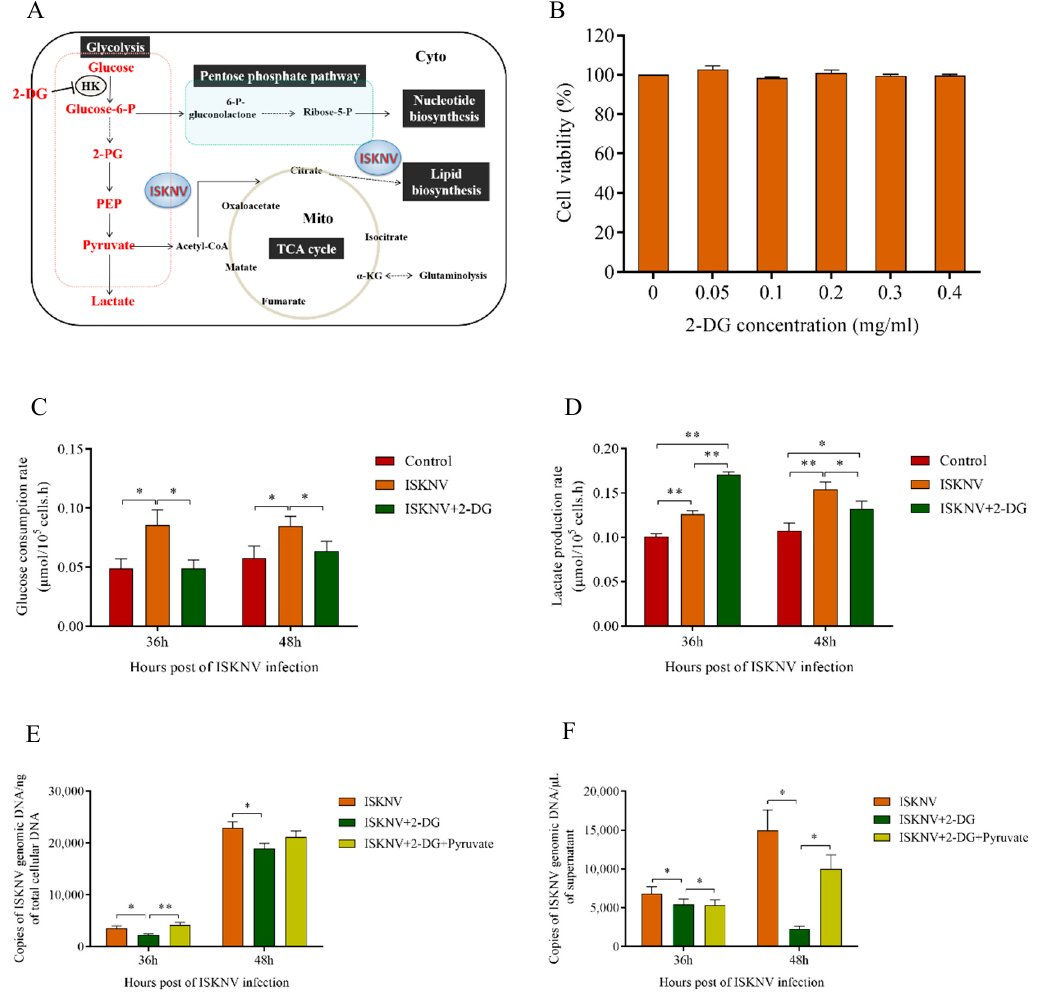
Figure 4. Aerobic glycolysis was required for efficient ISKNV multiplication. ( A ) Overview of cellular metabolism with glucose. 2-Deoxy-D-glucose (2-DG) inhibited glycolysis by inhibiting the expression of HK. ( B ) CPB cells were cultured in complete medium treated with 0–0.4 mg/mL of 2-DG, and the cell viability was detected by MTS assay at 72 hpi. ( C , D ) The glucose consumption and lactate production in ISKNV infected CPB cells. ( E , F ) CPB cells treated with 2-DG, 2-DG replenished with pyruvate, or without 2-DG were infected with ISKNV. Viral yield in cells and in supernatant was determined by real time PCR. * p < 0.05; ** p < 0.01.